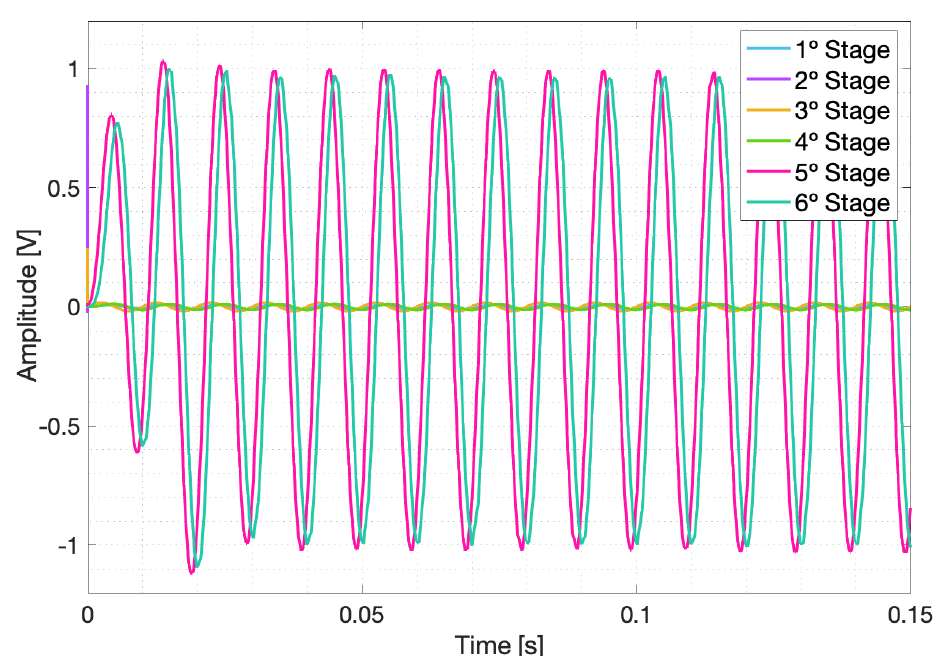
Figure 12. Graphs of each conditioning circuit 2 stage when f = 100